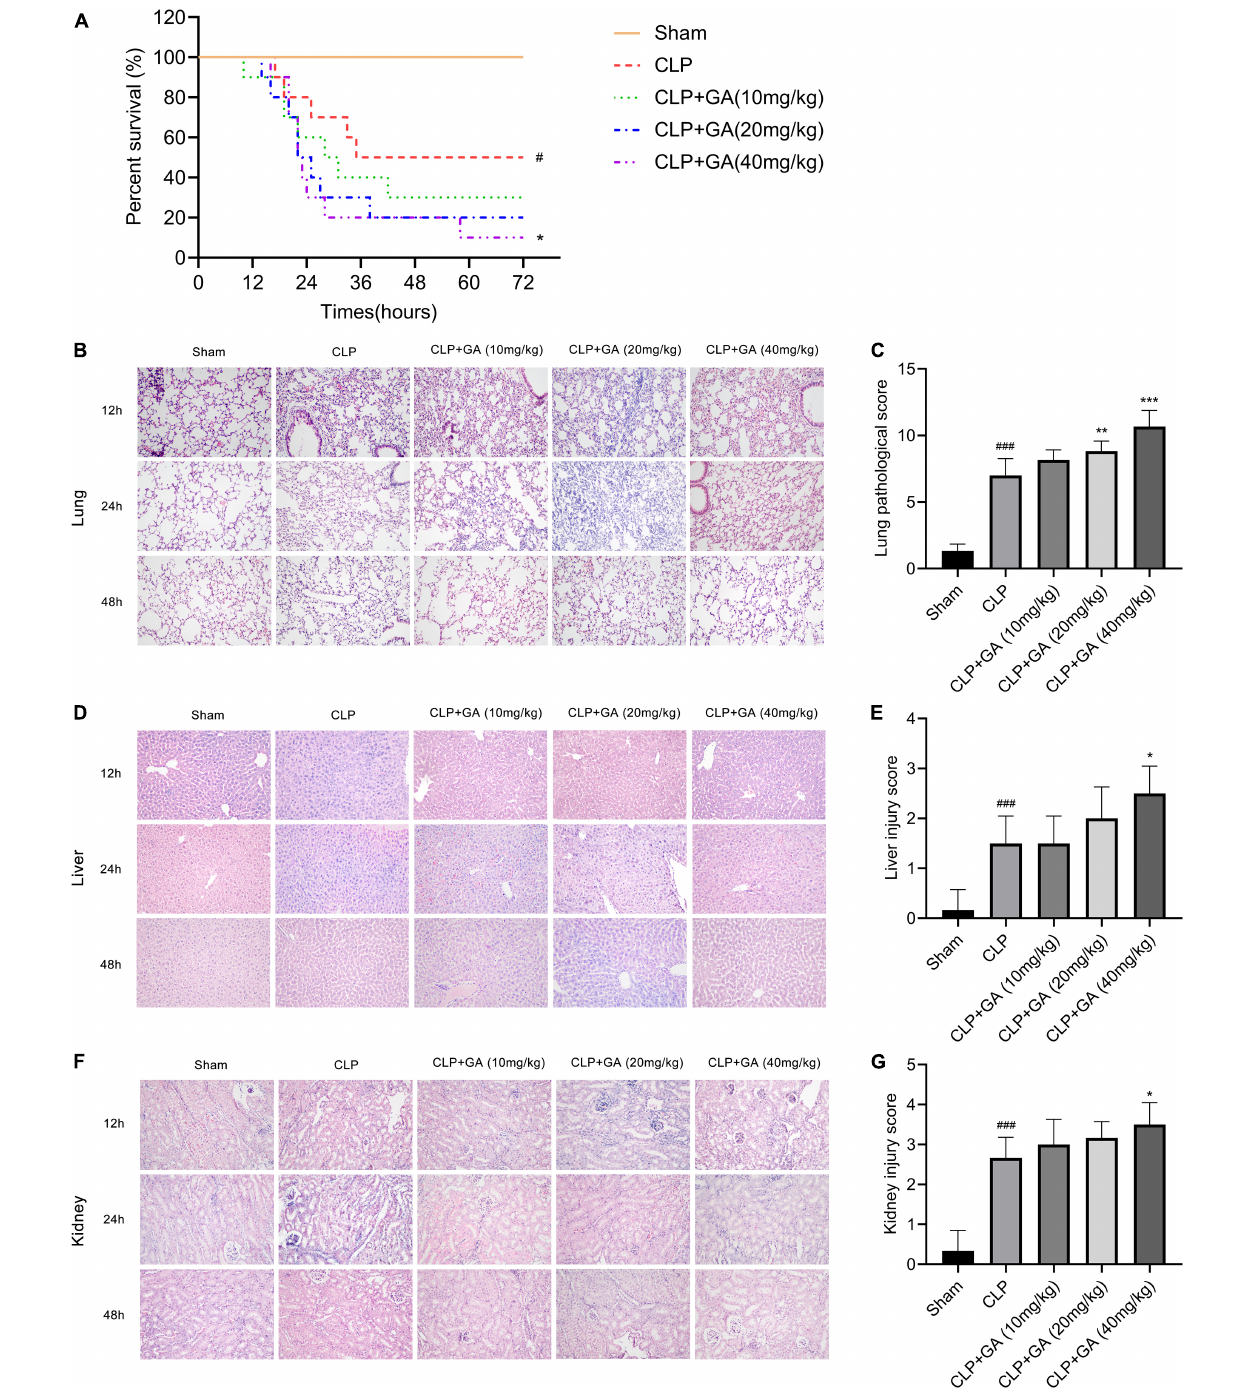
FIGURE2 Ginkgolic acid (GA) reduces survival rate and aggravates sepsis-induced organ pathological damage. (A) Kaplan-Meier survival curve for mice 72 h after the cecal ligation and puncture (CLP) operation ( n = 10). The status of the mice was observed every hour and the death of the mice was recorded. Data were calculated with the mean ± SD. # P < 0.05 versus the Sham group; ∗ P < 0.05 versus the CLP group. Pathological changes of organs in mice were observed by H&E stain, during CLP-induced sepsis for 12, 24, and 48 h. Representative histopathological characteristics of (B) lungs, (D) liver, and (F) kidneys by H&E staining. Histological scores of CLP mice at 24 h treated with GA or vehicle were shown in (C,E,G) . Data were calculated with the mean ± SD ( n = 6). # P < 0.05, ### P < 0.001 versus the Sham group; ∗ P < 0.05, ∗∗ P < 0.01, ∗∗∗ P < 0.001 versus the CLP